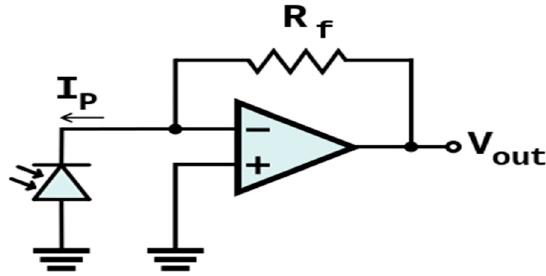
Figure 4. Basic circuit of the trans-impedance amplification (TIA).